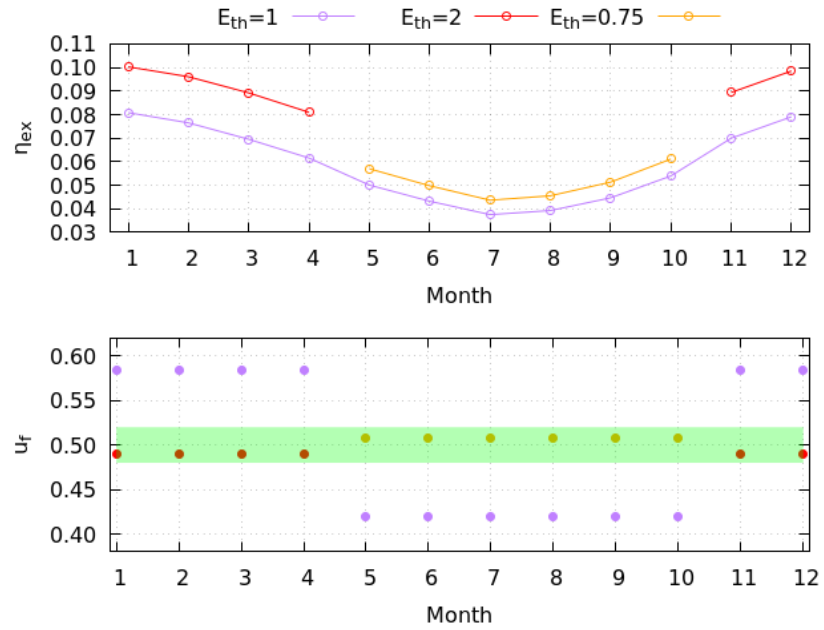
Figure 20. The exergy efficiency and final moisture content of the baseline scenario in the Brescia climate year 2018 at different operating conditions; starting from inputs of set1 (data in purple), we doubled (data in red) and reduced by 25% (data in orange) the thermal